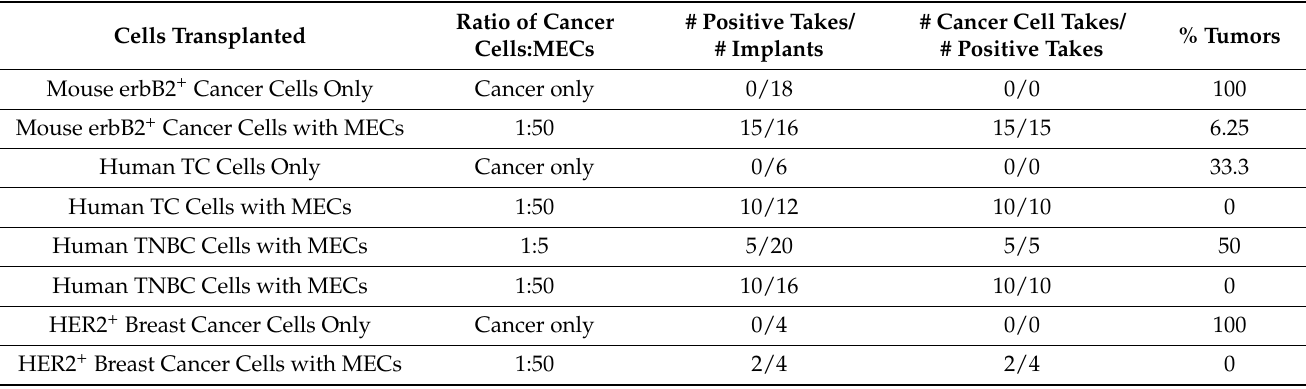
Table 1. Compilation of results of studies where cancer cells are redirected by the normal mammary microenvironment